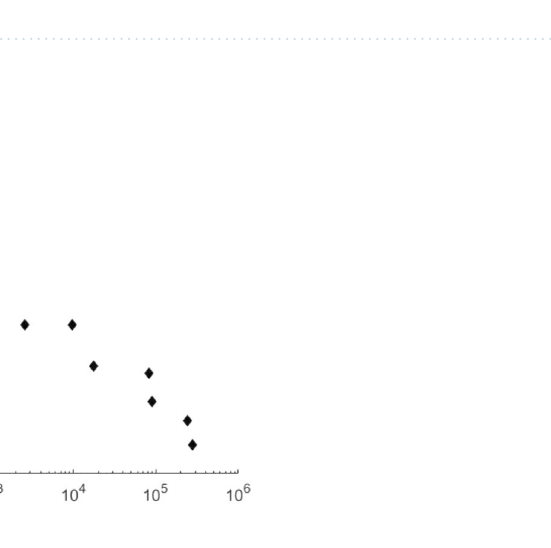
4 γ 85 10 3 k B T µm −1 ( A ) and, 3 µm and = = ×